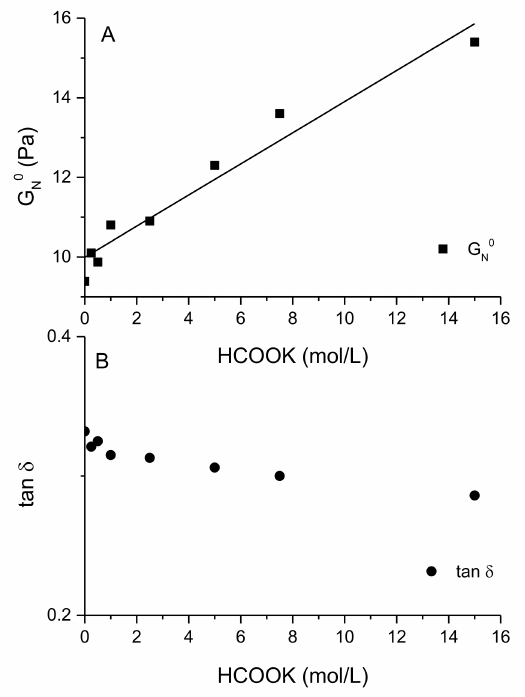
Figure 3. Evolution of the plateau modulus ( A ) and the minimum of tan δ ( B ) with potassium formate concentrations for fresh XG solutions at 0.5% ( w/v